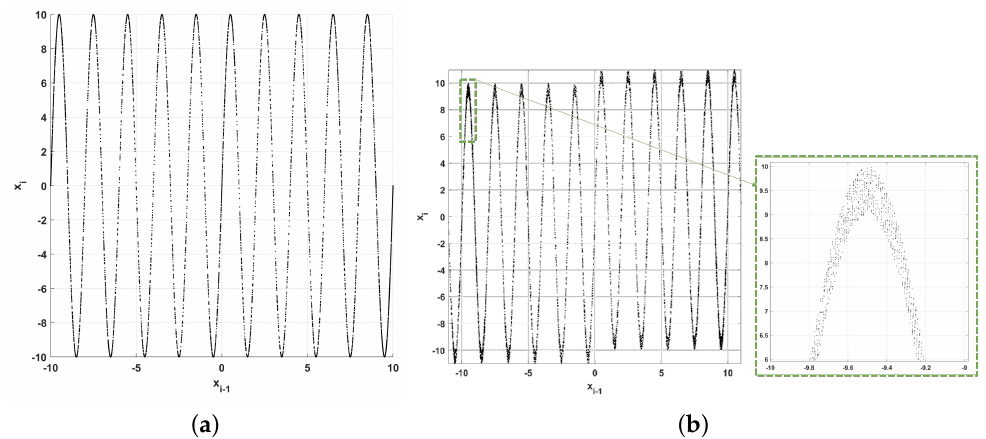
Figure 9. Two-dimensional phase diagrams for the sine map (24) and the modified sine map (25), for k = 10, a = 100, N = 1.